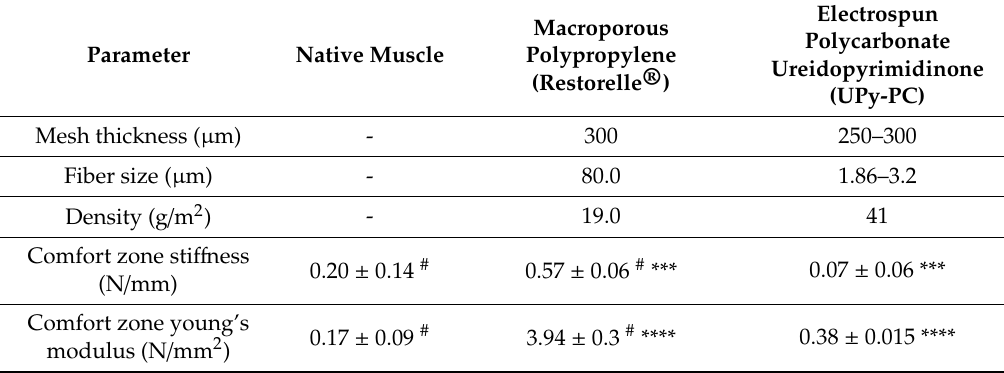
Table 1. Characteristics of meshes used in the study. Biomechanical parameters are displayed as mean ± SD.